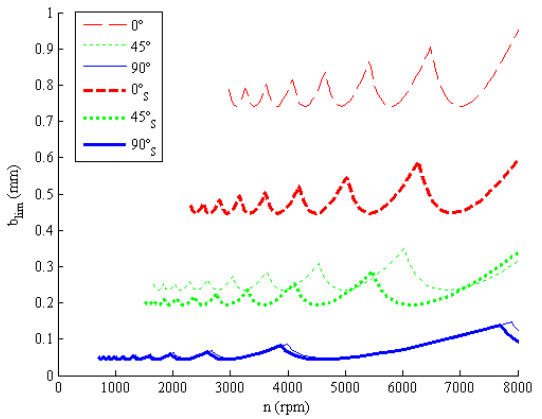
Figure 8. Chatter stability lobes of the two models with different ply angles.